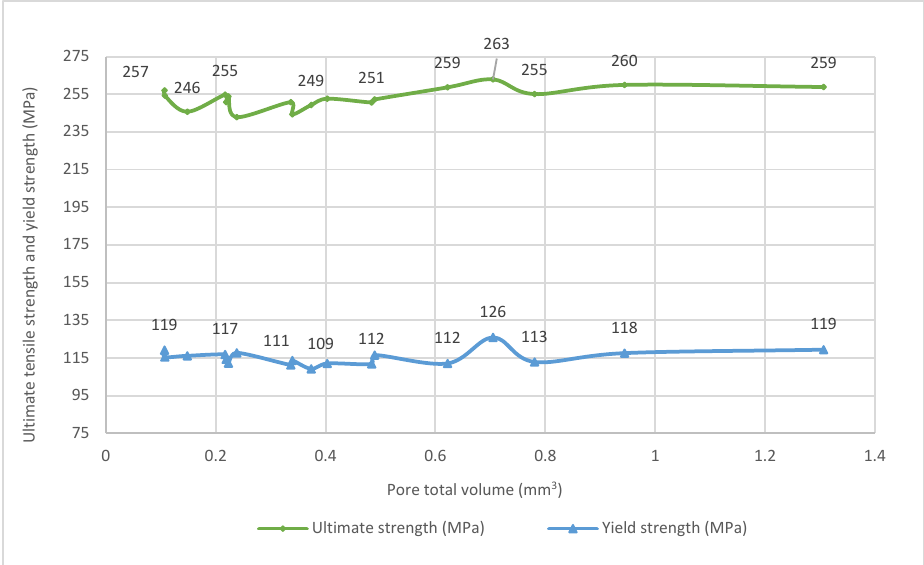
Figure 12. Ultimate tensile strength and yield strength versus the pore total volume.